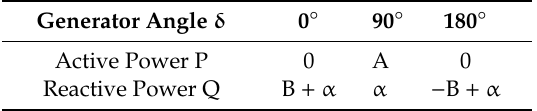
Table 1. The relationship between the generator angle and active and reactive